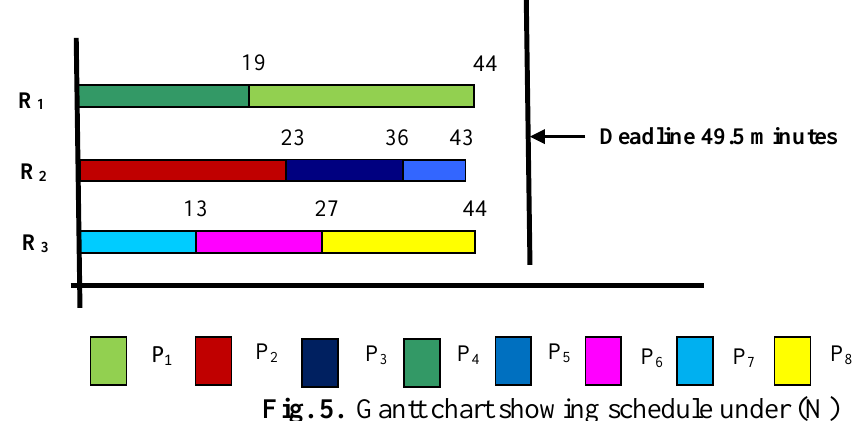
Fig. 5. Gantt chart showing schedule under (N)